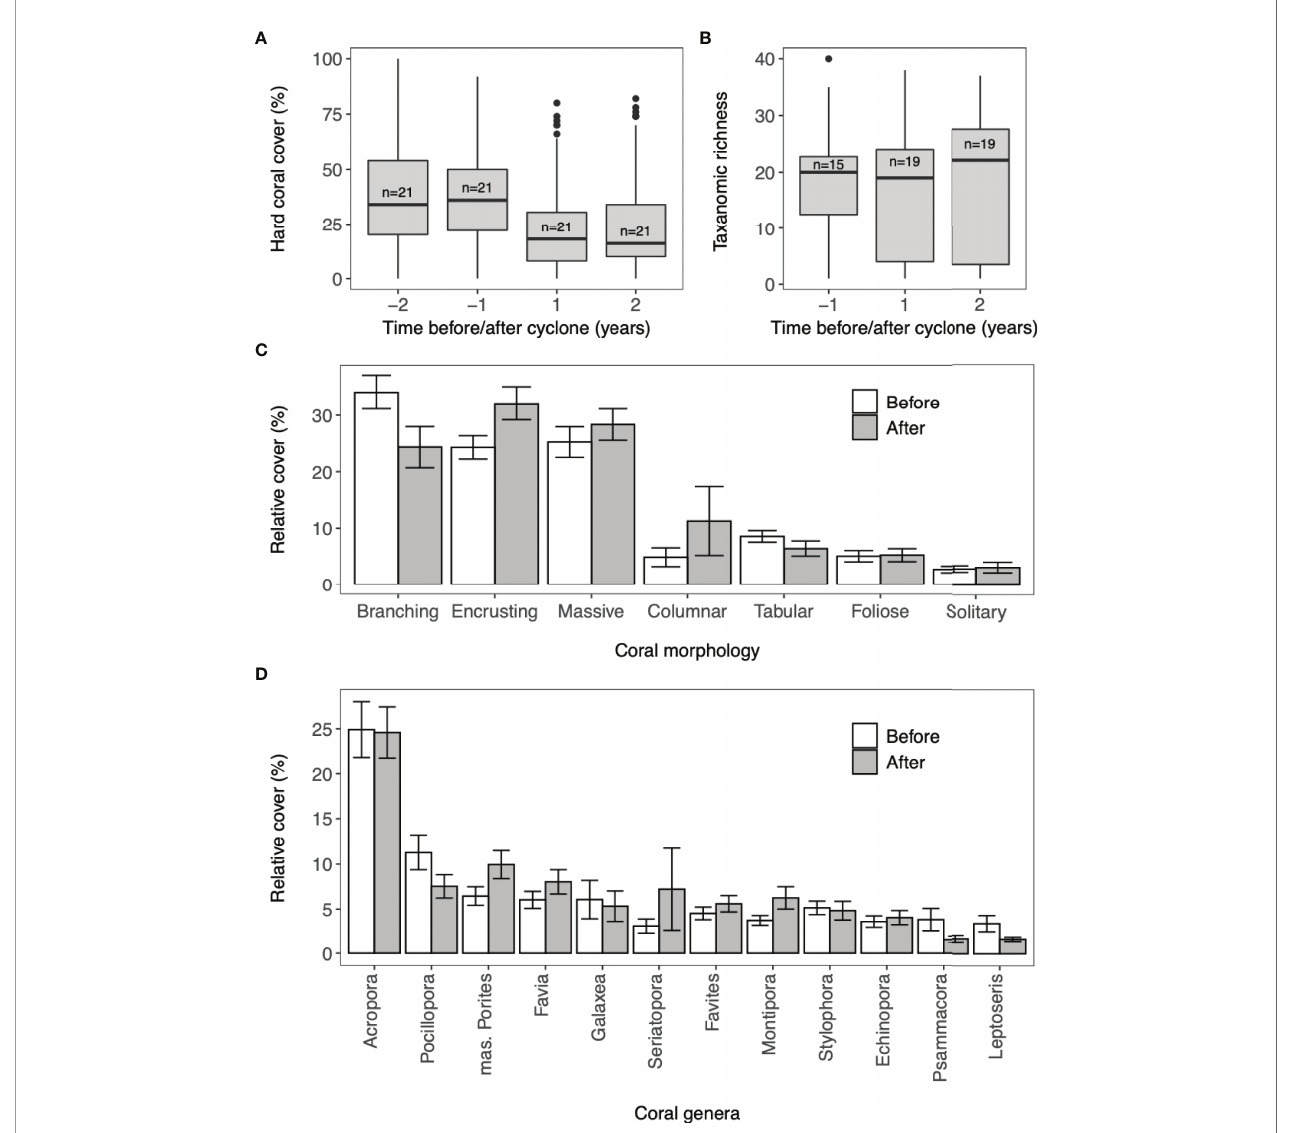
FIGURE 2 | (A) Hard coral cover and (B) mean taxonomic richness (C) mean relative cover of coral morphologies and (D) mean relative cover of coral genera at reef sites in the Velondriake Locally Managed Marine Area before and after Cyclone Haruna (22nd February 2013). Values are for adult coral colonies with diameter >10cm. (A, B) The solid line in the box represents the median; the top and bottom of the boxes represent the 25th and 75th percentiles; the whiskers above and below the box extend no further than 1.5*the interquartile range; the dots represent outliers and (n) is number of sites. N is number of sites. (C, D) Values are for surveys within one year before and one year after Cyclone Haruna and bars are standard